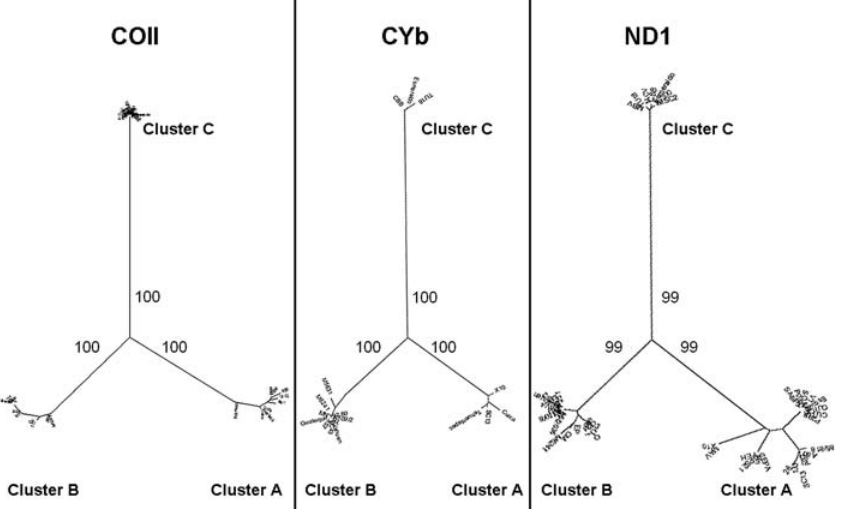
Figure 3. NJ Trees Obtained from the Sequences of Three Mitochondrial Genes of T. cruzi: COII, CYb, and ND1 The numbers in the three main branches indicate the percentage bootstrap values. For COII the strains the following clades are displayed: clade A: 1004, 1006, 1502, Col18/05, Cuica, Cutia, RBI, RbII, SilvioX10; clade B: sublineage IIc—222, 231, 3869, M6241, Mn, sublineages IId and IIe—CLBrener, 1022, SO3, Tula; clade C: 1014, 1043, 169/1, 1931, 200pm, 209, 577, 578, 580, 581, 803, 84Ti, Be62, Esmeraldo, GLT593, GMS, Ig539, JG, JHF, Mas1, MPD, TU18, Y. For CYb the strains are as follows: clade A: Cuica, SC13, Tehuentepec, X10; clade B: sublineage IIc—M5631, M6241, X109/2, sublineages IId and IIe—92.80, CL, Guateque, MN, SC43, Tulahuen, X57; clade C: CBB, Esmeraldo, TU18. For ND1 the strains are as follows: clade A: 133, 26, 85/818, A80, A92, CEPA, CUICA, CUTIA, Esquilo, MAV, OPS21, P0AC, P209, SABP3, SC13, SO34, TEH, V121, Vin, X10; clade B: sublineage IIc—CM, M6241, X109/2, X110/8, X9/3, sublineages IId and IIe—CL, 86/2036, 86–1, EPP, P251, P63, PSC-O, SO3, Tulahuen, VMV4; clade C: CBB, Esmeraldo, MBV, MCV, MSC2, TU18, X-300. DOI: